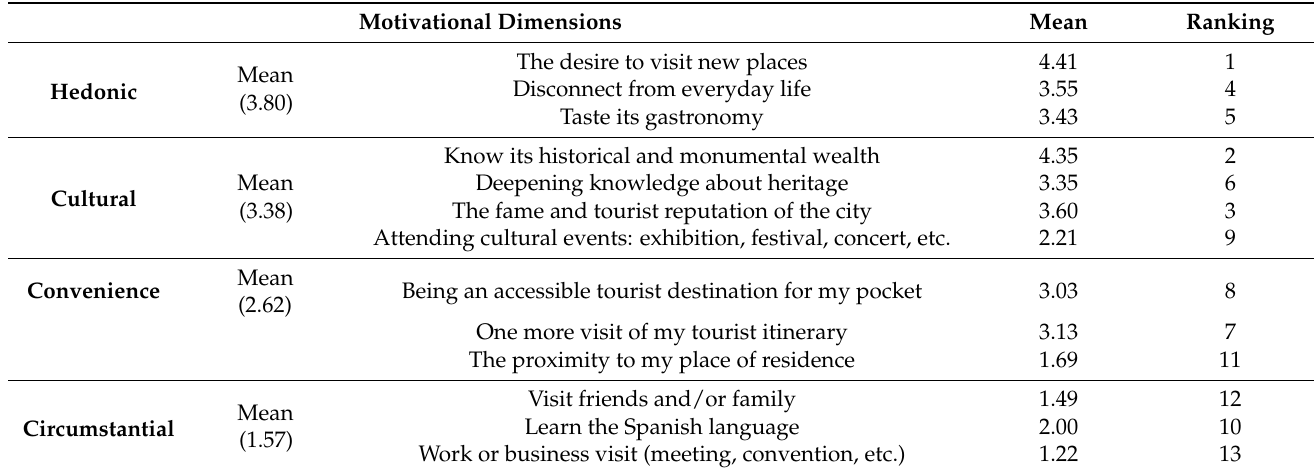
Table 2. Motivational dimensions of visiting Granada.